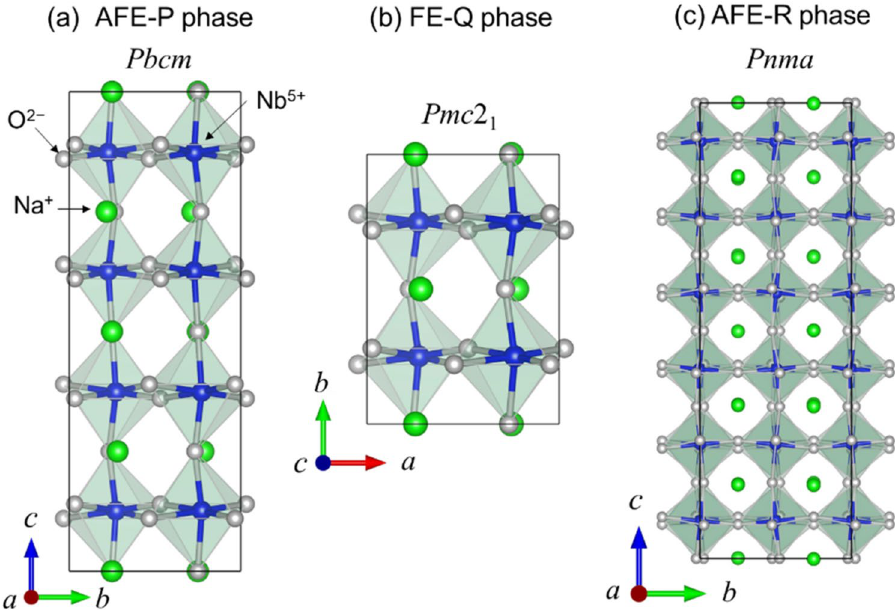
Figure 1. Crystal structures of NaNbO 3 : ( a ) AFE-P ( Pbcm ) phase, ( b ) FE-Q ( Pmc 2 1 ) phase and (c) AFE-R ( Pnma ) phase. The green, blue, and gray balls indicate Na + , Nb 5+ and O 2− , respectively. The data of the AFE-P, FE-Q and AFE-R phases are referenced from Ref. 51 (ICDD No. 00–033–1270), 52 (ICDD No. 01–079–7429) and 15 (COD No. 4329527),